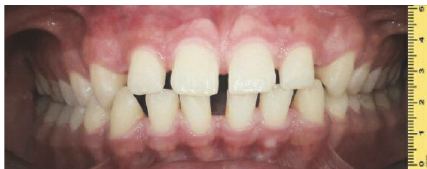
Figure 1: Intraoral frontal view before orthodontic treatment shows generalized diastema.